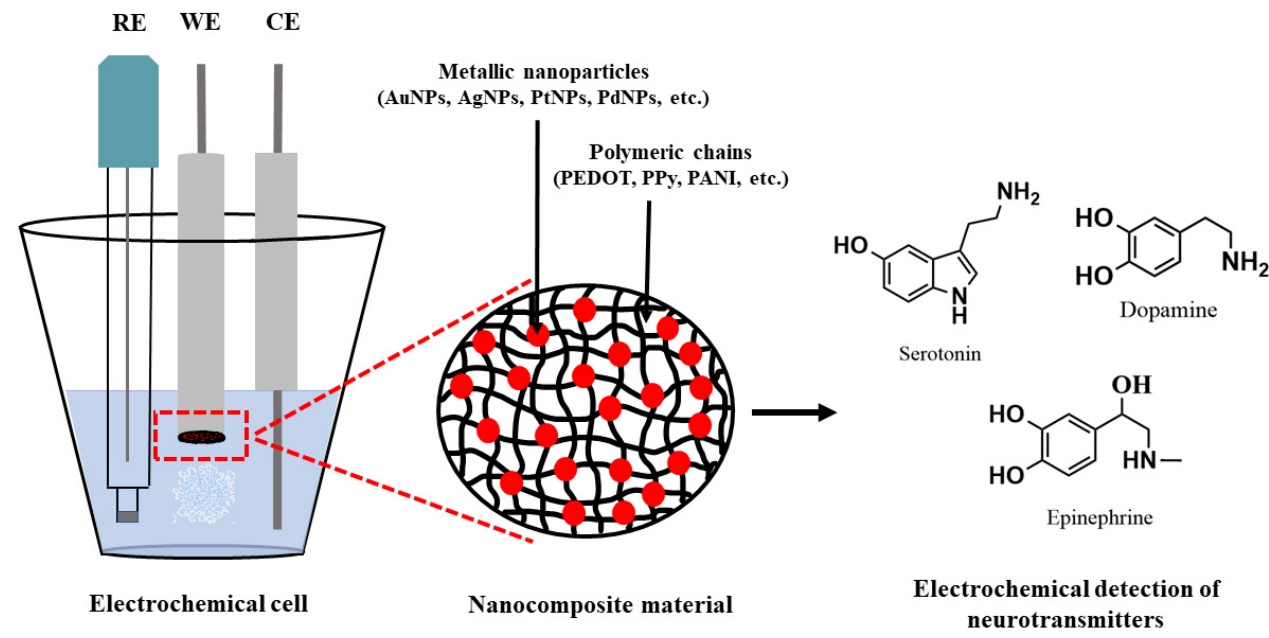
Figure 3. Schematic illustration of the specific design of electrochemical sensors based on nano- composite materials implemented for NT sensing.